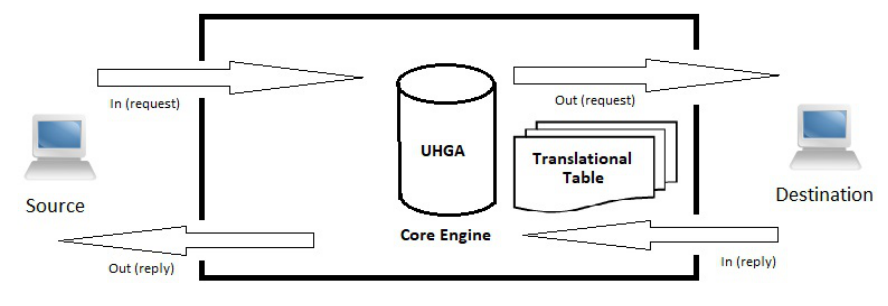
Figure 1. The Secure Dynamic Middleware black